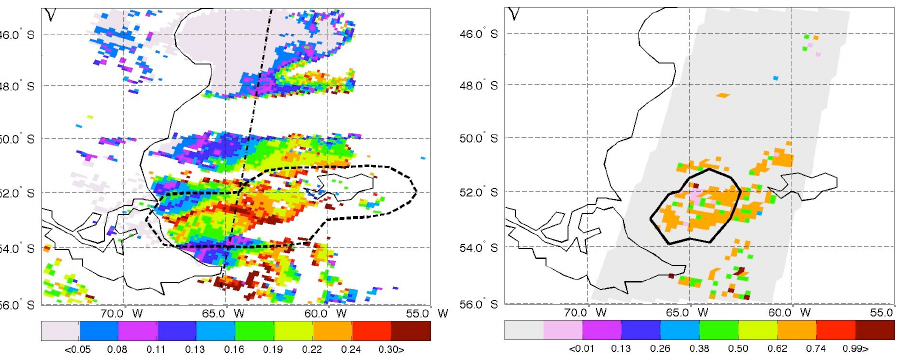
Fig. 7. MODIS-Terra AOTs (left panel) and MISR non-spherical fraction (right) for pixels with AOTs > 0.16 (pass time near 13:55UTC). The MODIS image includes the envelope of pixels witn non-zero dust concentration according to HYSPLIT for a model run unconstrained by surface observations (thick dashed line). Also, the image shows the north-south track of GLAS five hours later. The image on the right shows the envelope of non-zero dust concentrations (solid thick line) for HYPSLIT model run constrained by surface obs.